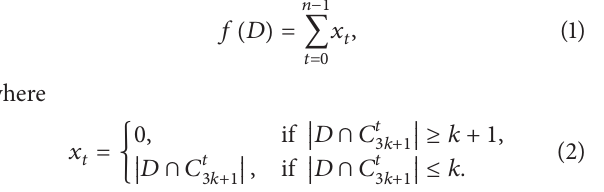
Figure 2: Pattern of the dominating set shown in Figure 1.